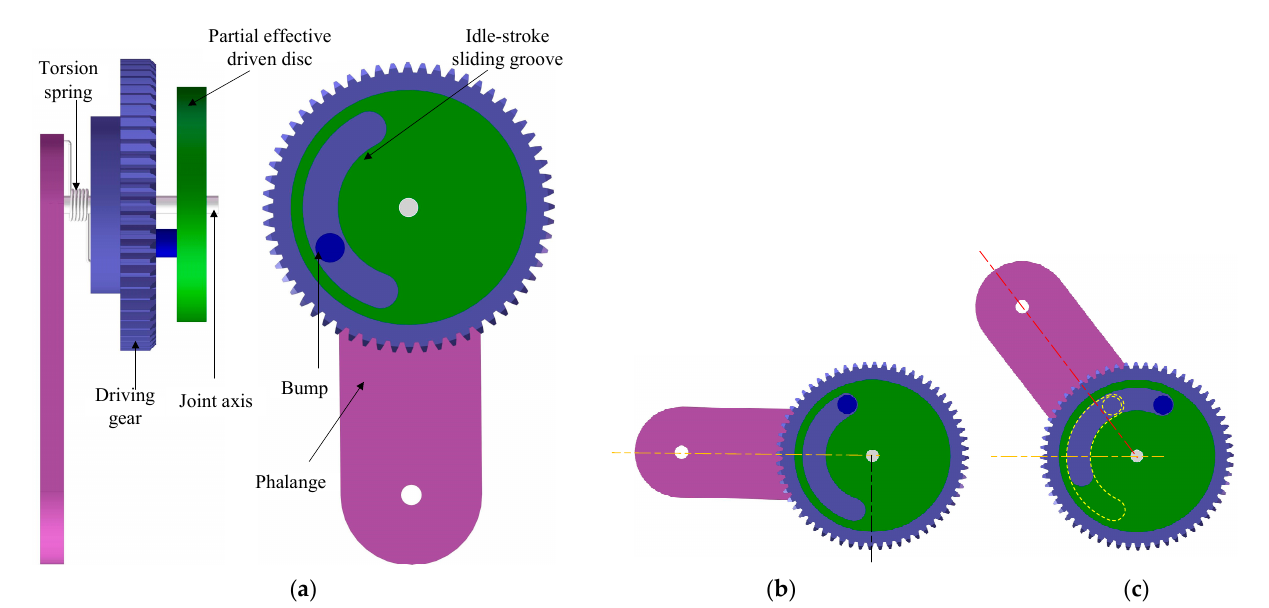
Figure 3. Partial Effective Transmission Mechanism: ( a ) Initial position; ( b ) Idle ‐ stroke stage; ( c ) Effective ‐ stroke stage.